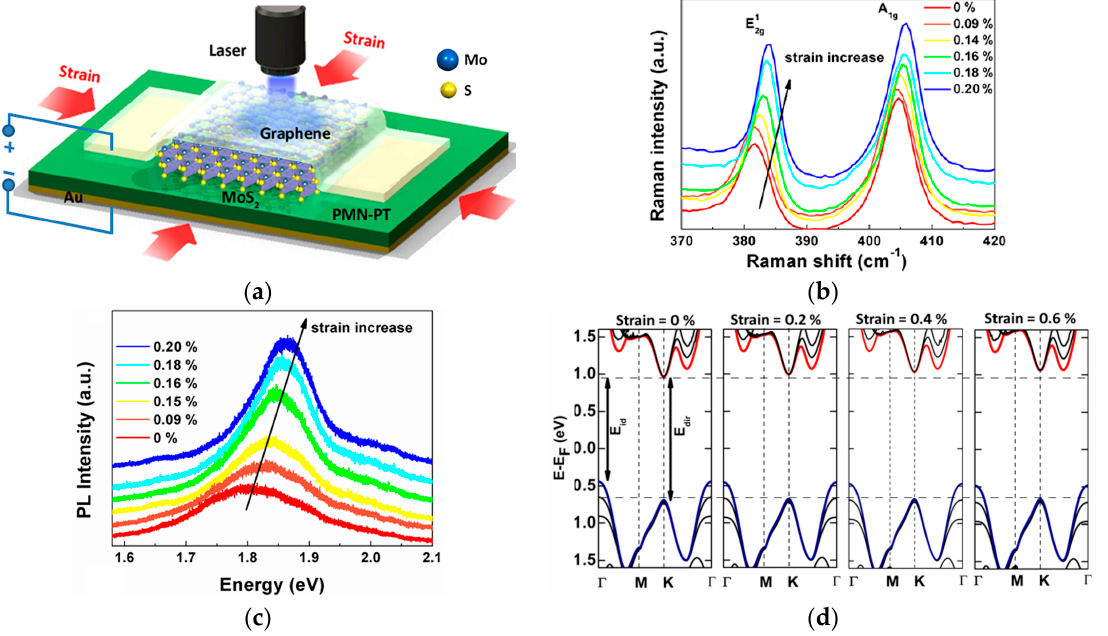
Figure 5. Electronic structure and band gap of a 2D semiconductor influenced by strongly correlated materials through strain transfer. ( a ) Schematic diagram of Raman and PL measurements on MoS 2 . MoS 2 is sandwiched between a piezoelectric PMN-PT substrate and a graphene top electrode; ( b ) Raman spectra of a trilayer MoS 2 under various applied strains; ( c ) PL spectra of MoS 2 under various strains; ( d ) Band structures of ABA-BAB stacking trilayer MoS 2 under 0.0%, 0.2%, 0.4%, and 0.6% biaxial compressive strain (Yeung Yu Hui et al. [59]).